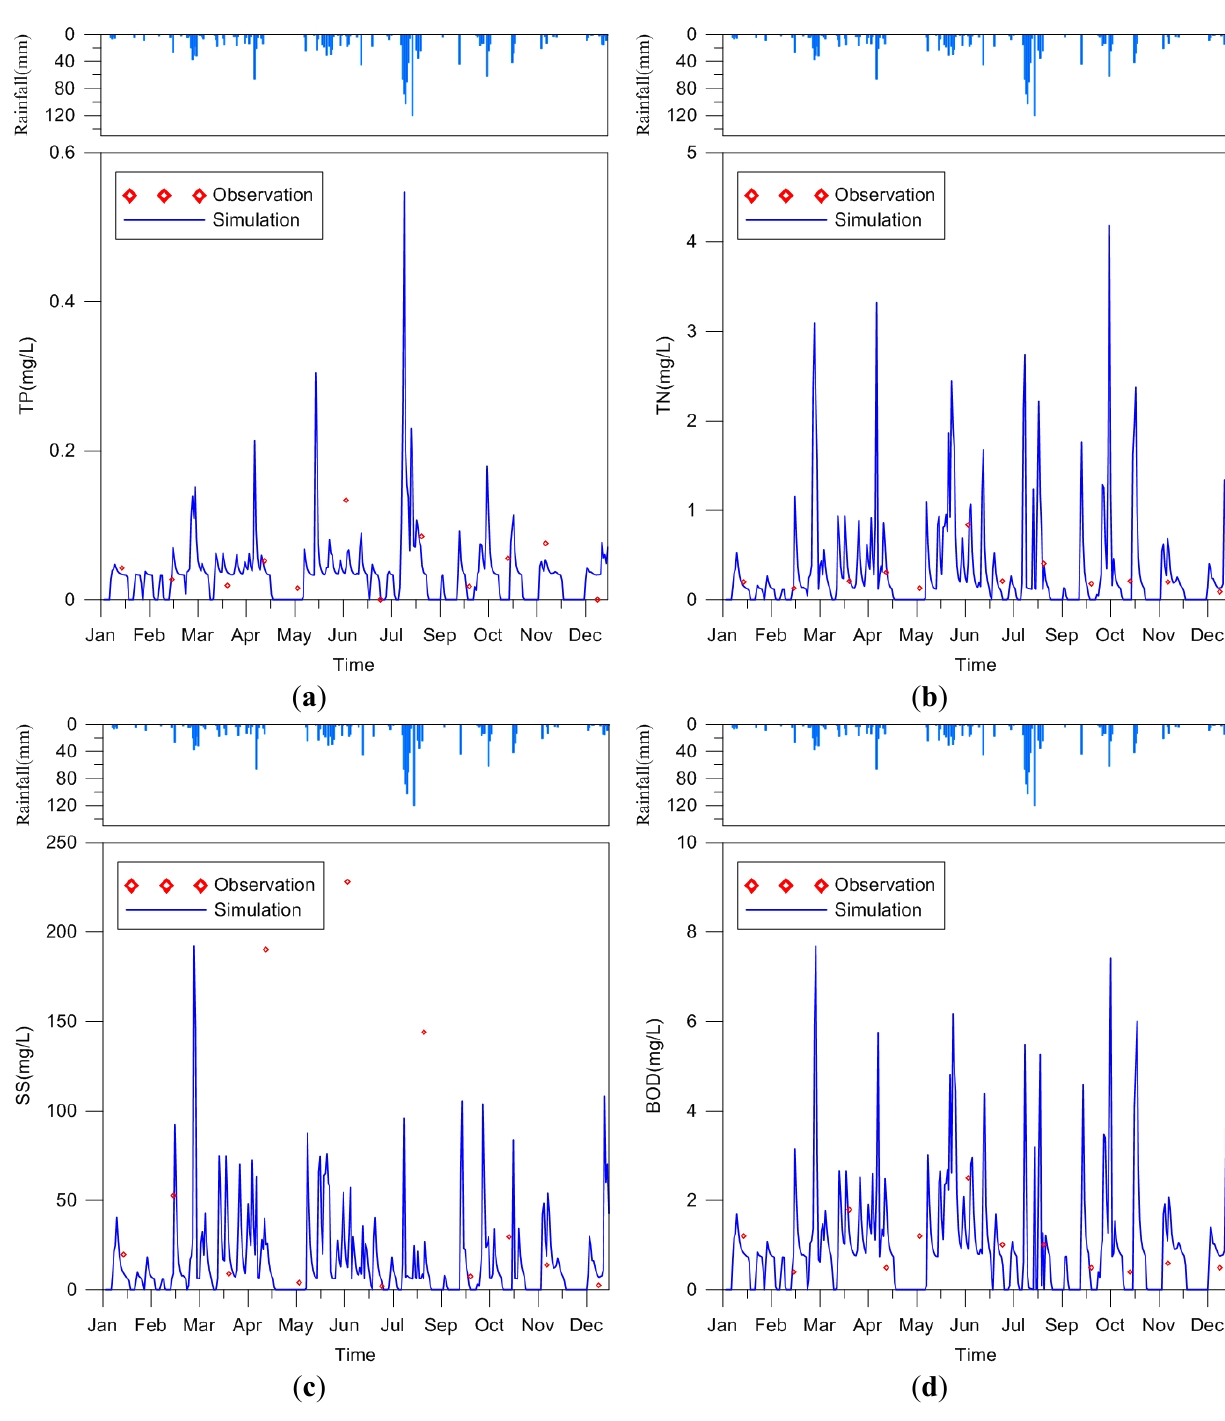
Figure 5. Verification results from water quality simulations for: ( a ) TP (total phosphorous);